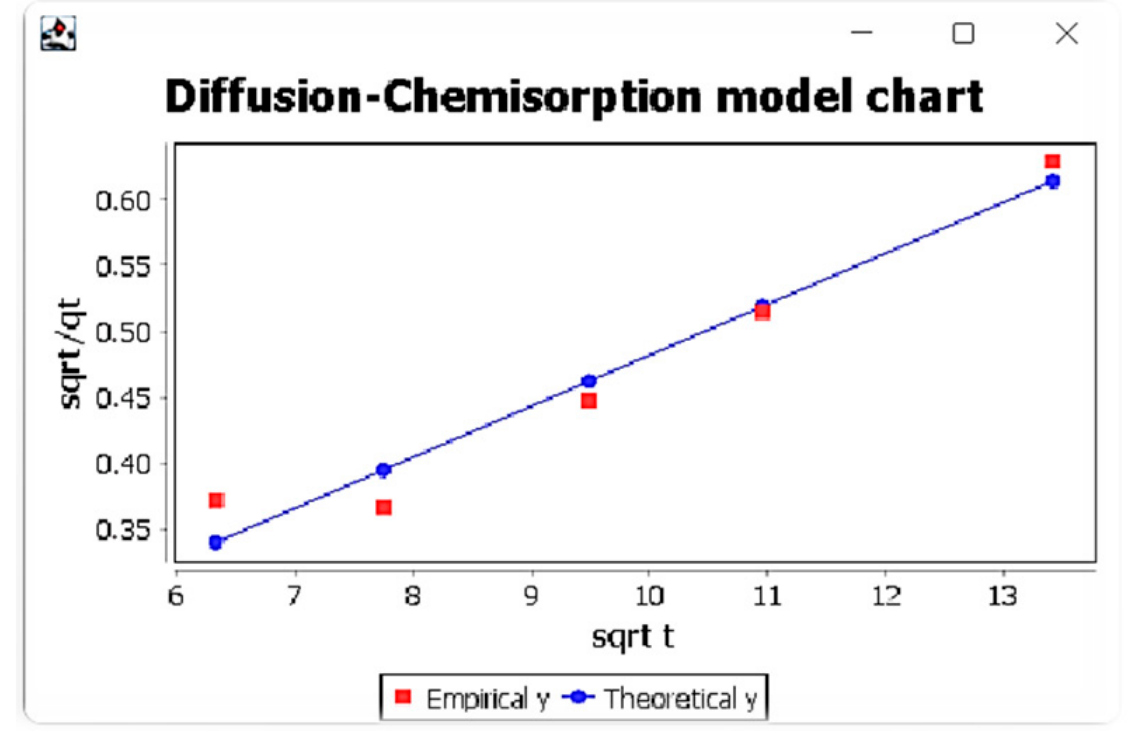
Figure 4. Window with diffusion-chemisorption model results and comparison of experimental and theoretical data graph for Eu ions.